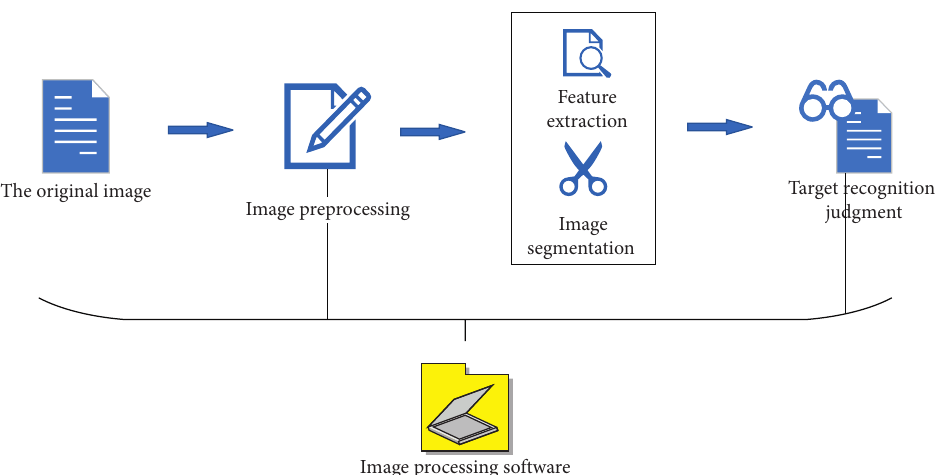
Figure 5: Analysis of target